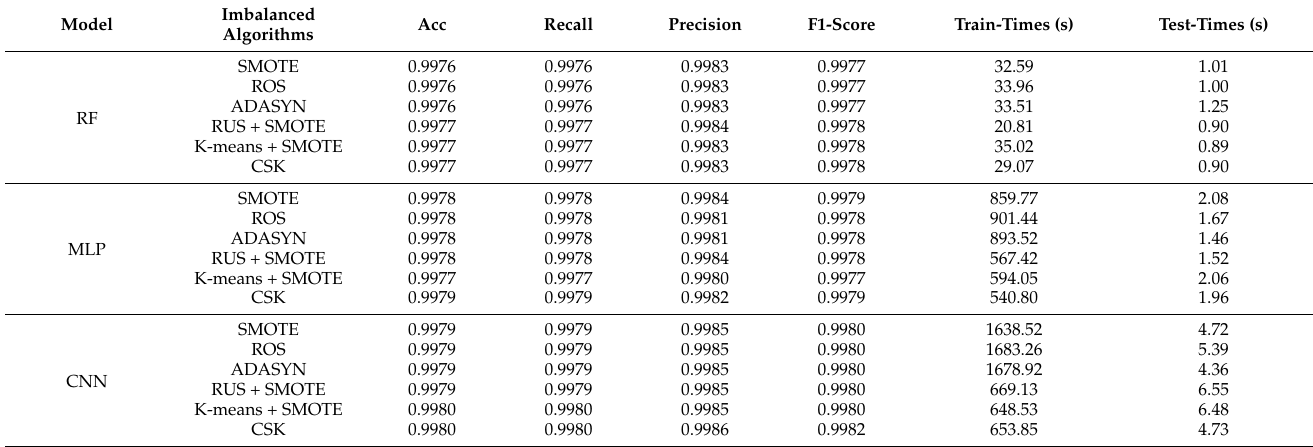
Table 8. Multi-classification Performance Results on CICDS2017